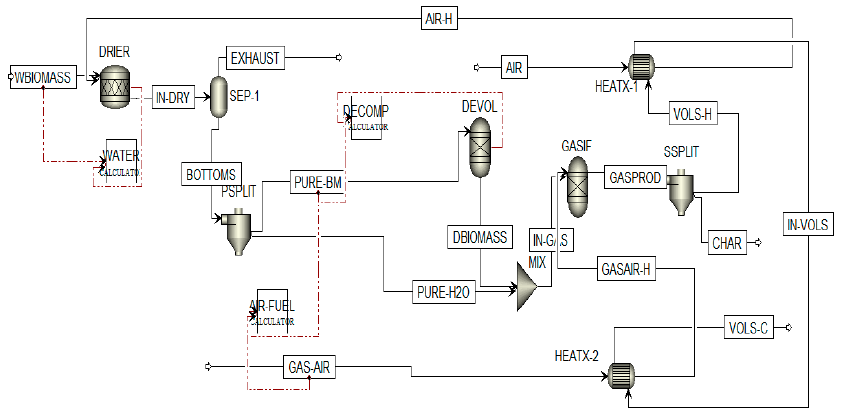
Figure 2. Aspen Plus simulation for gasification.